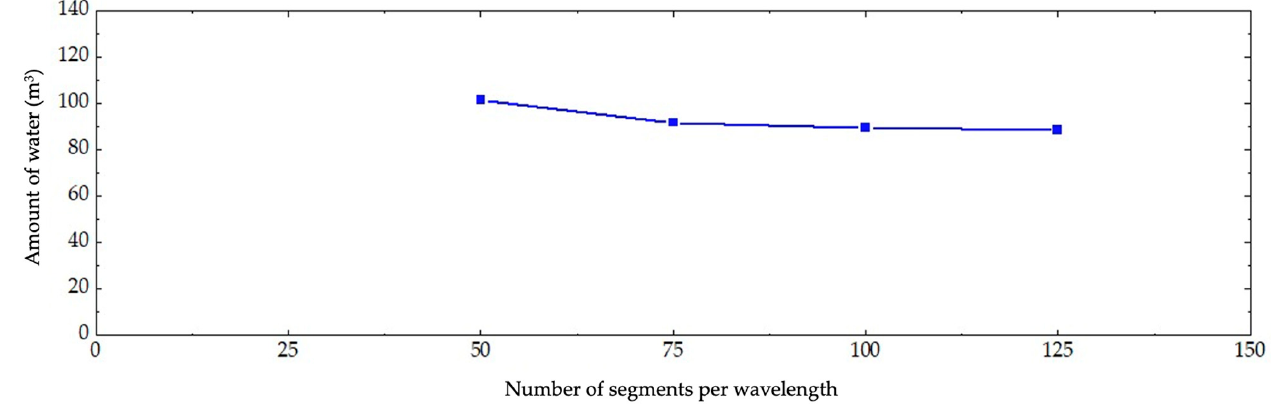
Figure 9. Mesh convergence test for region R2 of the computational domain.